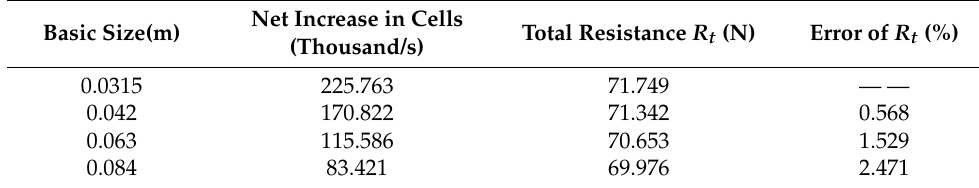
Table 3. Mesh convergence analysis for steady turning.